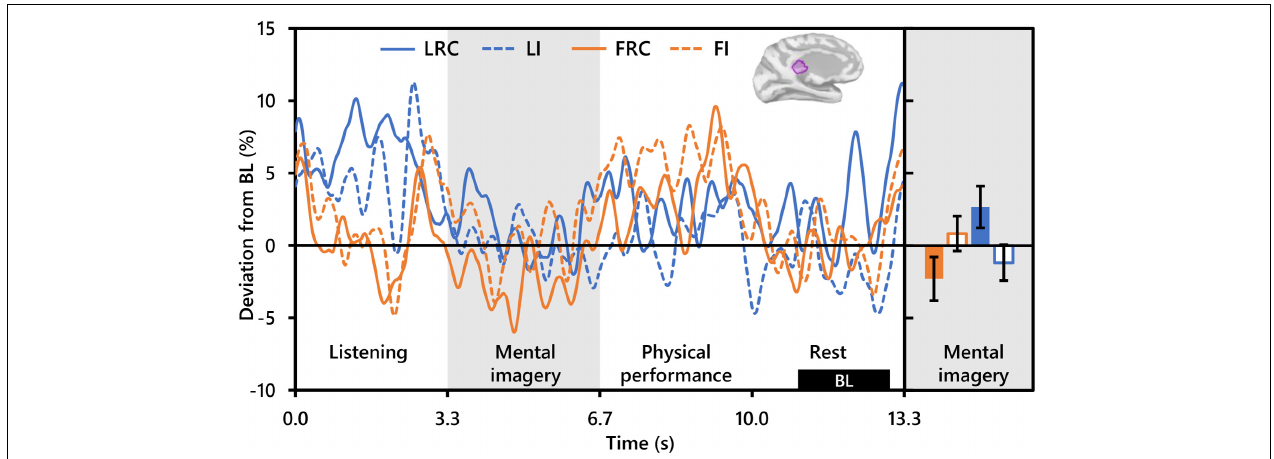
FIGURE 4 | Interaction between role and playing condition with theta activity ( N = 20). The time-series waveforms (left) show overall mean theta (5–7 Hz) activity in the left significant cluster in the isthmus cingulate (see displayed cortical map) across one communication epoch for the Rhythm Copy (RC) and Improvise conditions for Leaders and Followers separately and temporally aligned to facilitate visual comparison. The histogram (right) shows representative overall mean activity over the mental imagery period in the same cluster for each role/condition. LRC, leader rhythm copy; LI, leader improvise; FRC, follower rhythm copy; FI, follower improvise; BL, baseline period. Error bars are standard